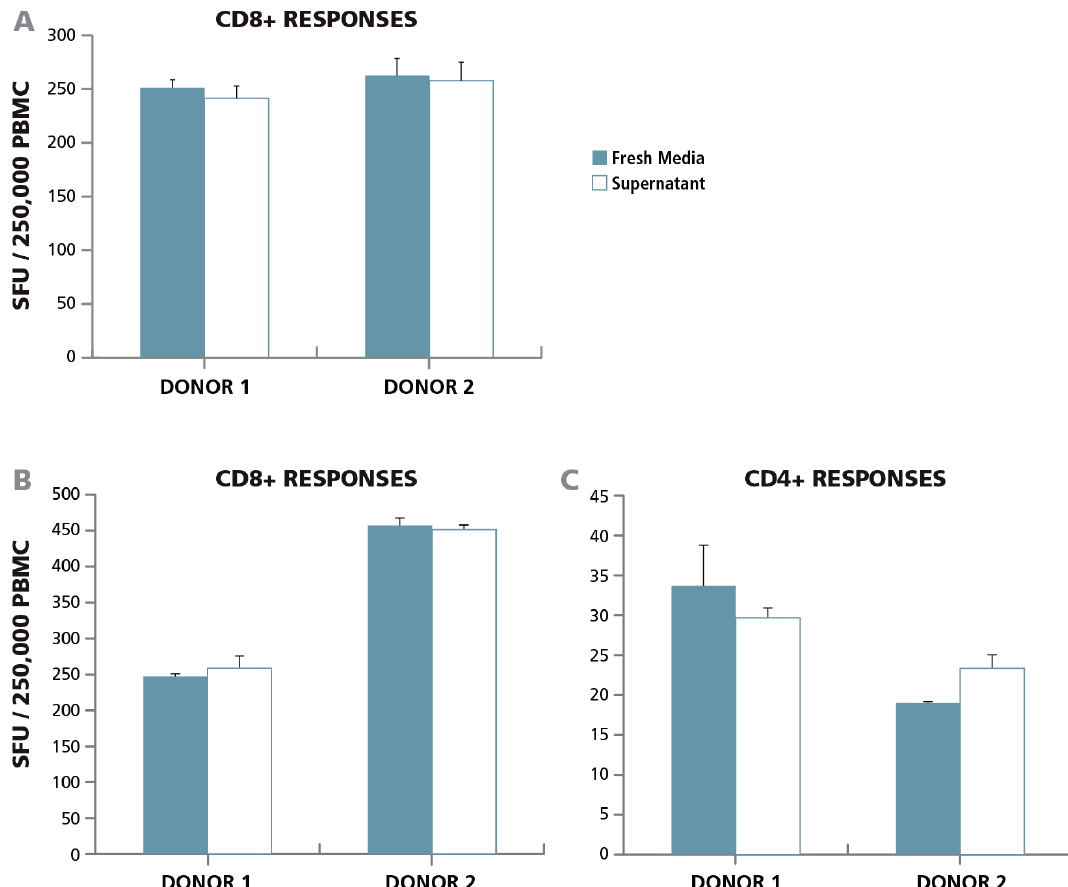
Figure 3. Bystander apoptotic cells do not exert a paracrine effect on T cell activation. ( A ) B cells isolated from PBMC were incubated overnight with monoclonal anti-CD20 antibody (Rituximab) and the supernatant was added to an IFN- γ ELISPOT assay in which PBMC were stimulated with the CEF peptide pool. Spot formation in the presence of fresh culture medium (solid bars), or with the apoptotic supernatant (open bars) was compared for the two PBMC donors specified. ( B and C ) Two PBMC donors were rested overnight at 37 °C, and the supernatant form the PBMC samples was added to an IFN- γ ELISPOT assay to detect recall responses from ( B ) CD8 cells (using CEF peptide pool antigen) or ( C ) CD4 cells (using Mumps antigen). The number of spot forming units in the presence of fresh medium (solid bars) or supernatant from rested cells (open bars) was analyzed for the two